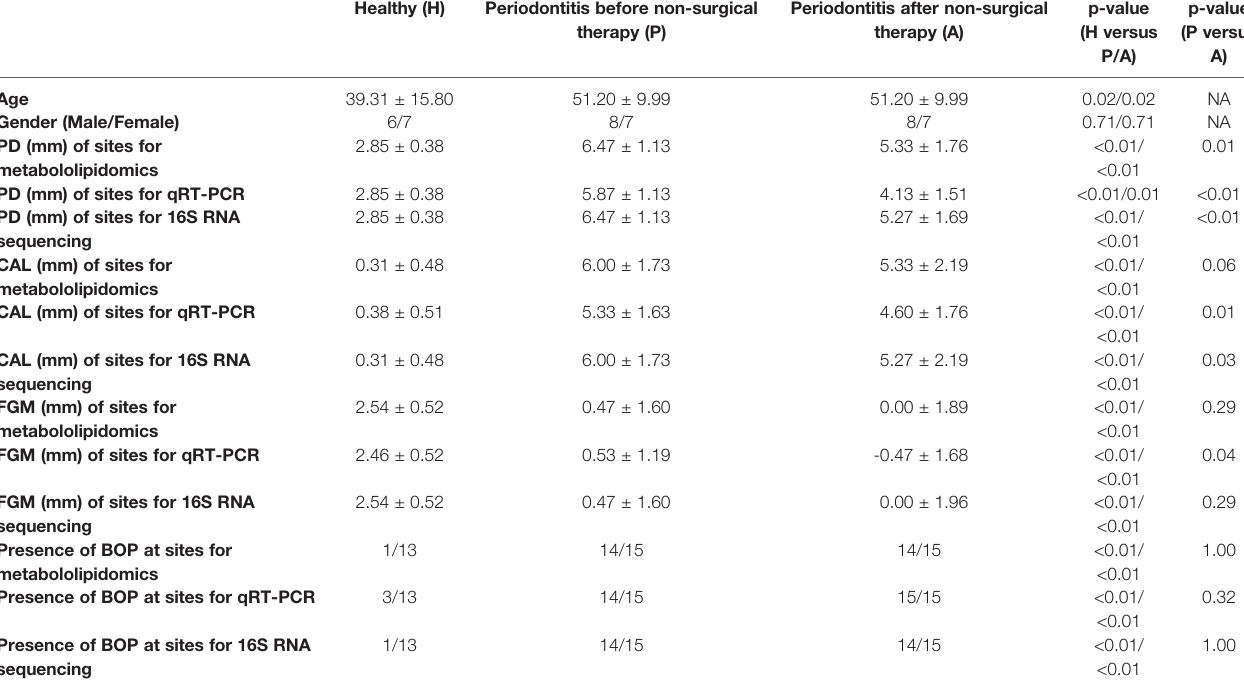
TABLE 1 | Characteristics of subjects and sample collection